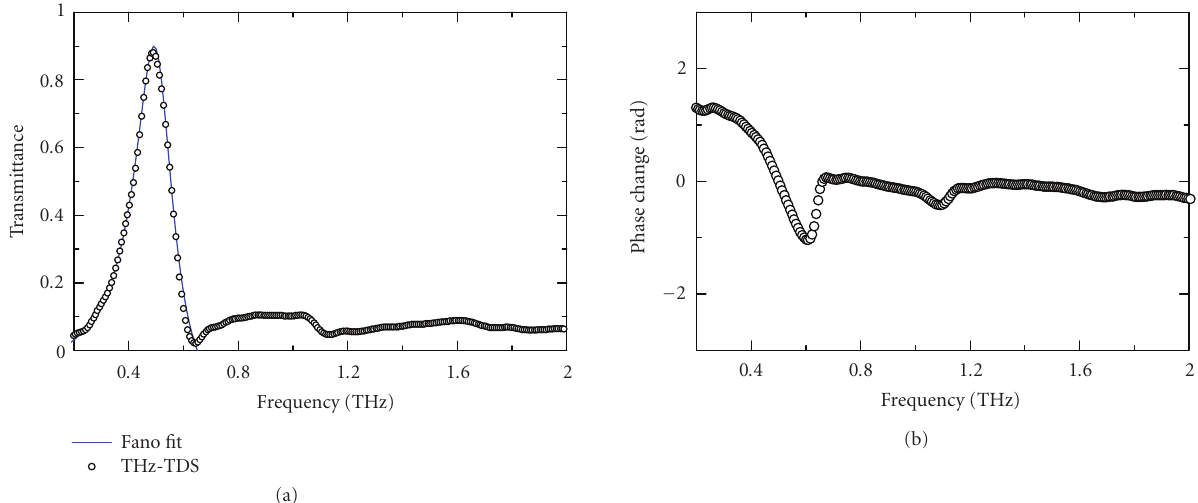
Figure 7: (a) Measured (open circles) and theoretical fit (solid curve) by the Fano model of frequency-dependent transmittance of the hexagonal array of 120 × 40 μ m 2 holes. The fitting parameters are q v = 26 . 5 ± 0 . 2, ω v /2 π = 0 . 49 ± 0 . 05 THz, Γ v /2 π = 0 . 16 ± 0 . 01 THz, and T b = (1 . 28 ± 0 . 1) × 10 − 3 for the [ ± 1,0] mode. (b) Corresponding data of phase